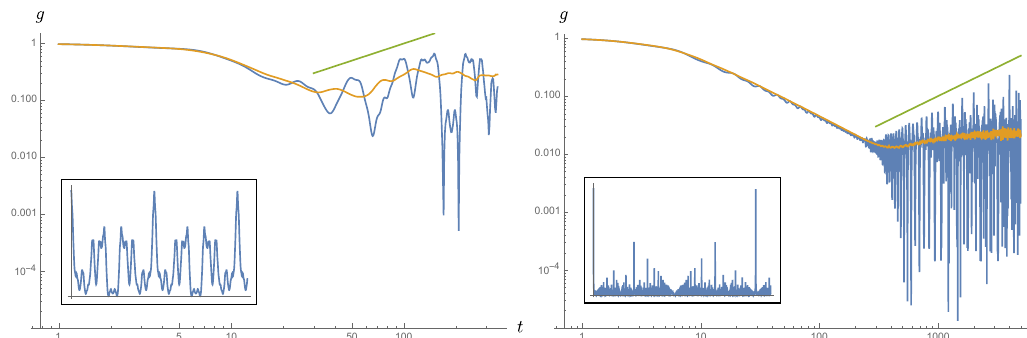
Figure 5 . The spectral form factor (blue) and its progressive time-averaged version (yellow) for the unitary minimal models with m = 5 (left) and m = 50 (right). We see the emergence of the dip, ramp, and plateau as we increase m . While the peaks in the non-averaged function grow linearly, the time-averaged function is sublinear. This can be seen by the green lines which are linear in t . The insets show the functions on linearly scaled